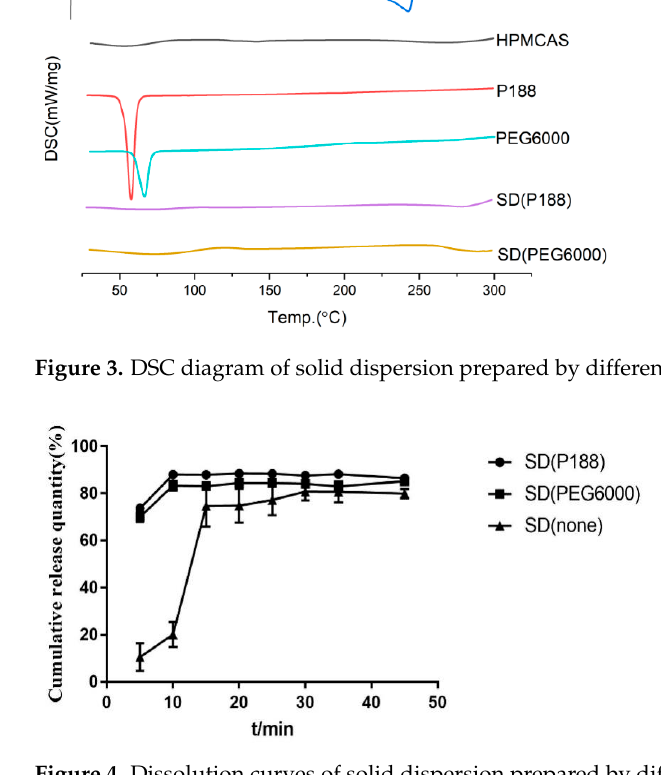
Figure 6. Dissolution curves of solid dispersion prepared by different cooling temperature. 2.3.4. Mass Ratio It can be seen from Figures 7 and 8 that when the carrier is 1:1, 1:3, 1:4, and 1:5, the dissolution in 5 min has reached about 80%. The rapid release of drugs in the early stage is easy to cause sudden release, which has an impact on the safety of drugs. Therefore, the drug loading ratio is 1:2. Figure 7. DSC diagram of solid dispersion prepared by different mass ratio.